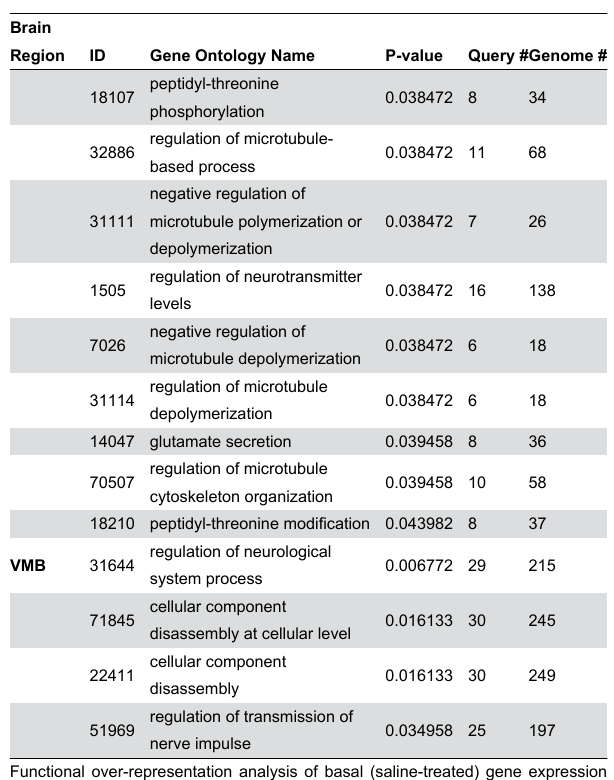
differences between control and Fyn null mice within NAC, PFC, and VMB.